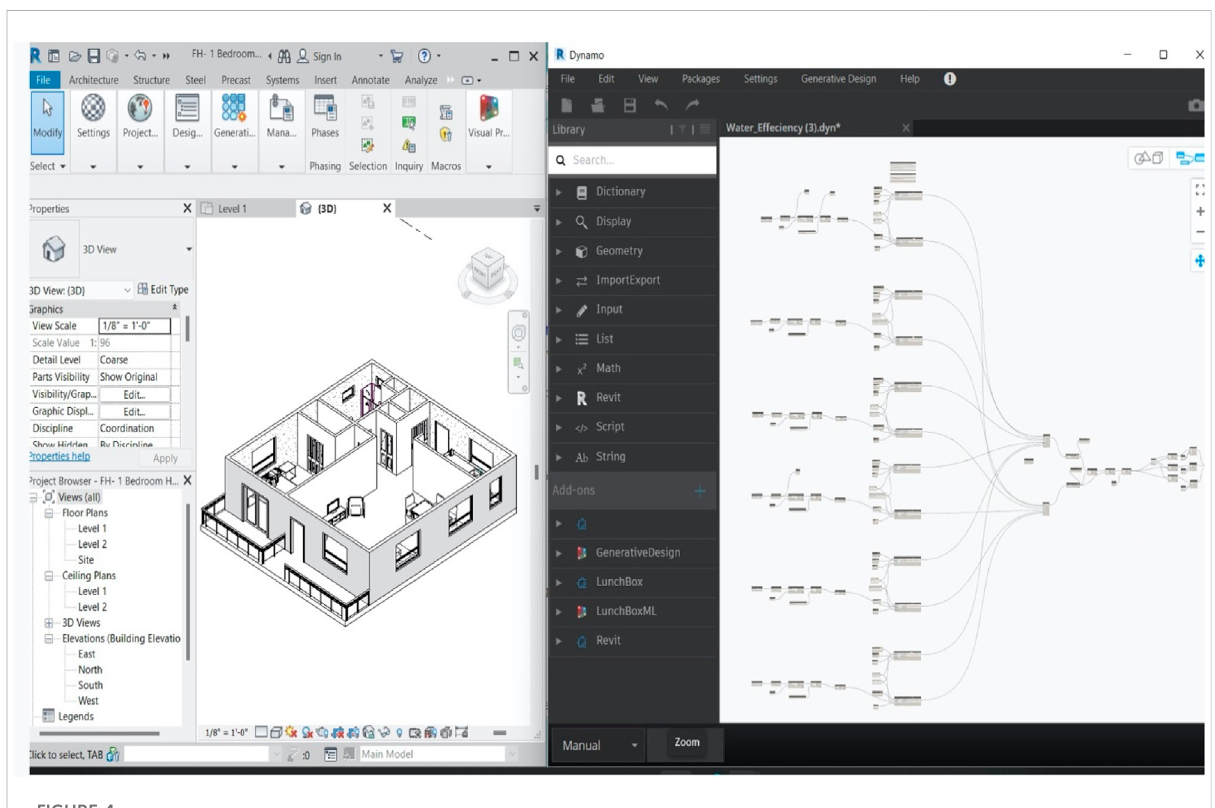
FIGURE 4 Revit and dynamo side by side